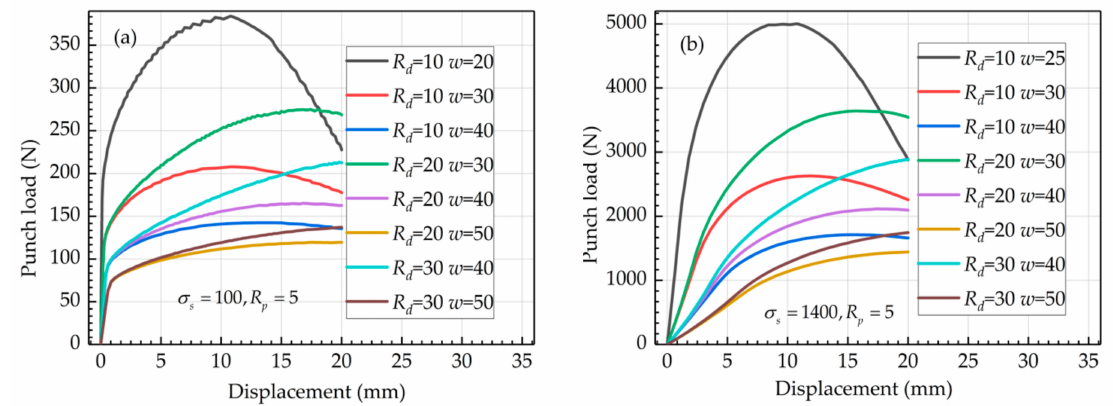
Figure 4. Stroke curve of bending force under di ff erent spans and di ff erent die fillets: ( a ) MYL; ( b ) MYH